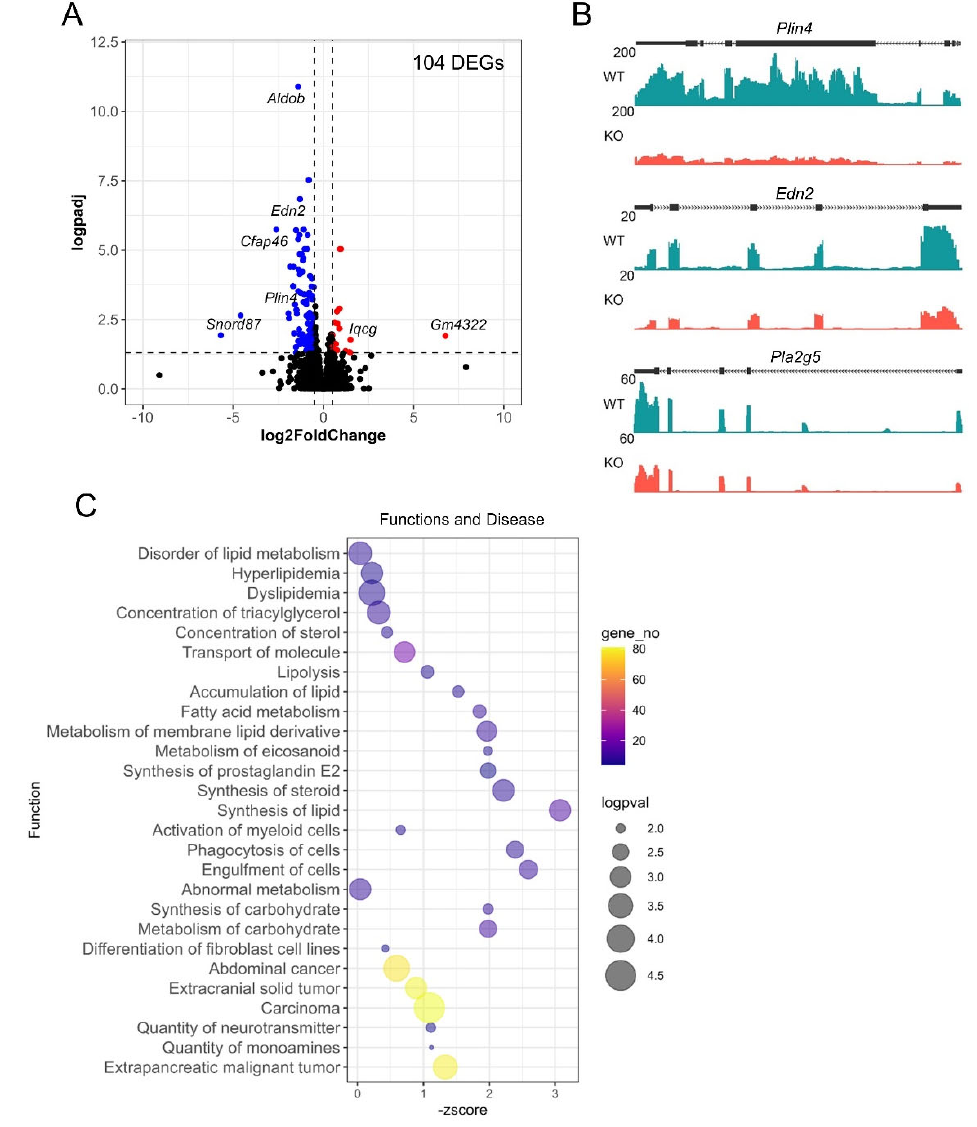
Figure 8. RNA-seq identifies PGR-regulation of stromal tissue. RNA-seq was performed on ovarian stromal tissue at 8 h post-hCG. ( A ) Volcano plot demonstrating the 104 differentially expressed genes (logFC ≥ 0.5 and padj ≤ 0.05) between PRKO and WT ovarian stromal tissue. Blue depicts downregulated and red depicts upregulated genes in PRKO stroma. ( B ) Example of Plin4 , Pla2g5 and Edn2 differential gene expression as visualized by number of reads mapped on the gene. ( C ) “Function and diseases” dysregulated in PRKO ovarian stroma based on IPA analysis of stromal DEGs. Similar functions are grouped and shown as log p ‐ value (size), the number of DEGs associated with the function (color) and z ‐ score indicating degree of downregulation ( X ‐ axis).